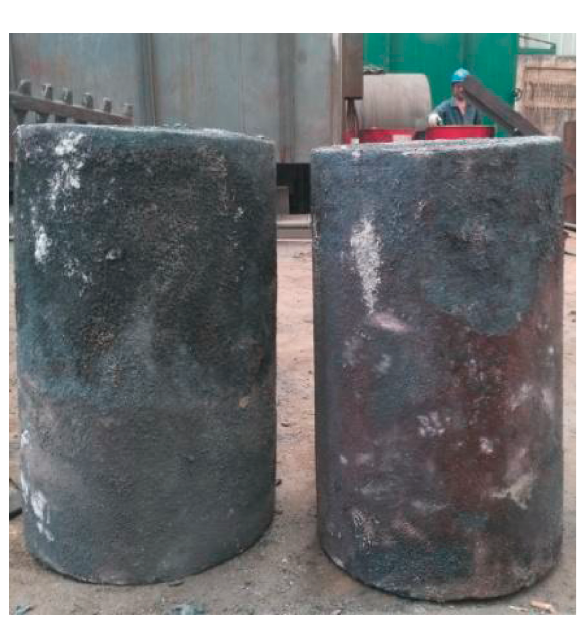
Figure 1: 35CrMoV steel